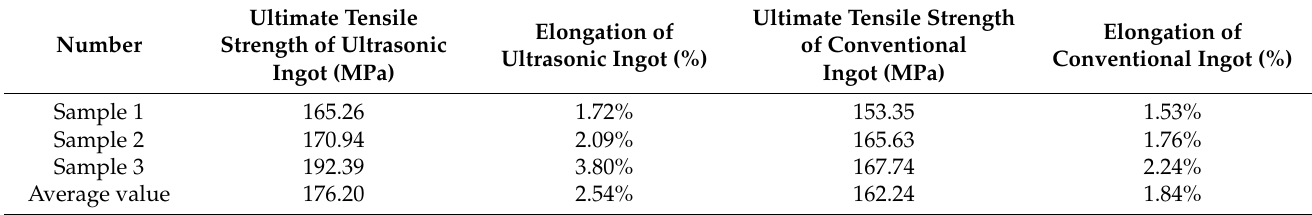
Table 4. Test results of tensile strength of tensile